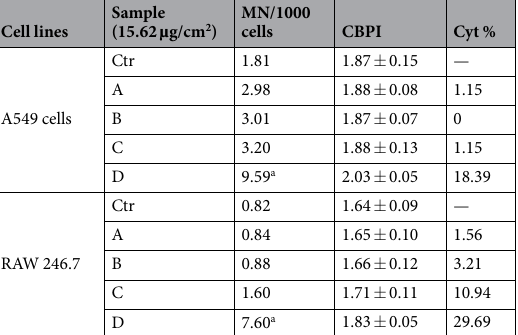
Table 3. Frequency of micronuclei (MN), cytokinesis-block proliferation index (CBPI) and cytostasis (Cyt) in A549 and Raw 267.4 cell lines either untreated (Ctr) or exposed to asbestos (D) or to slags powder of